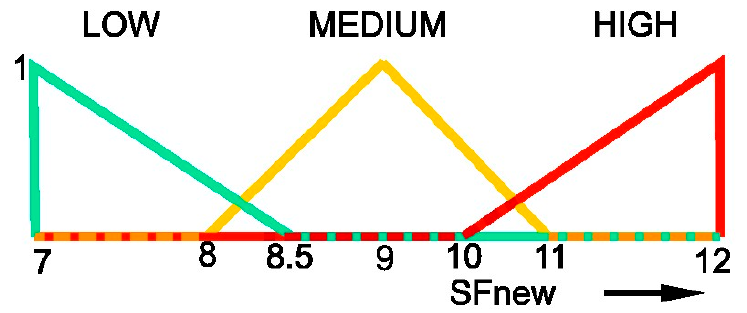
Figure 4. SFnew membership function .